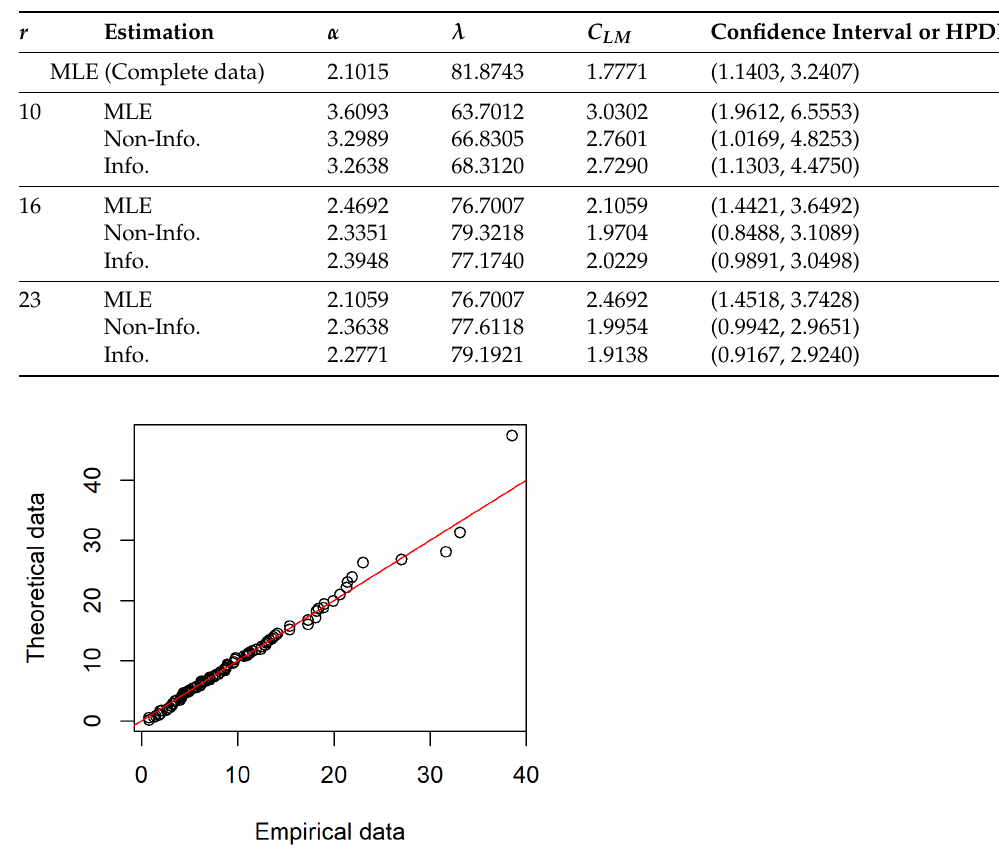
Table 4. Estimation results based on Example 1 ( n = 23 ball bearings and T = 87 in million revolutions).